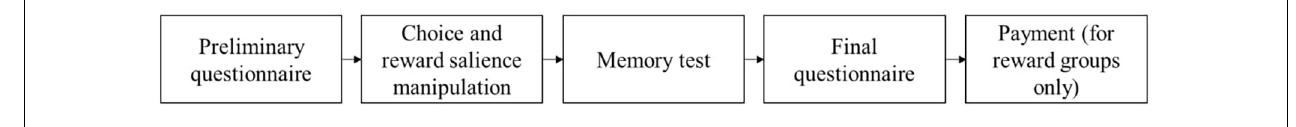
FIGURE 2 | Experimental